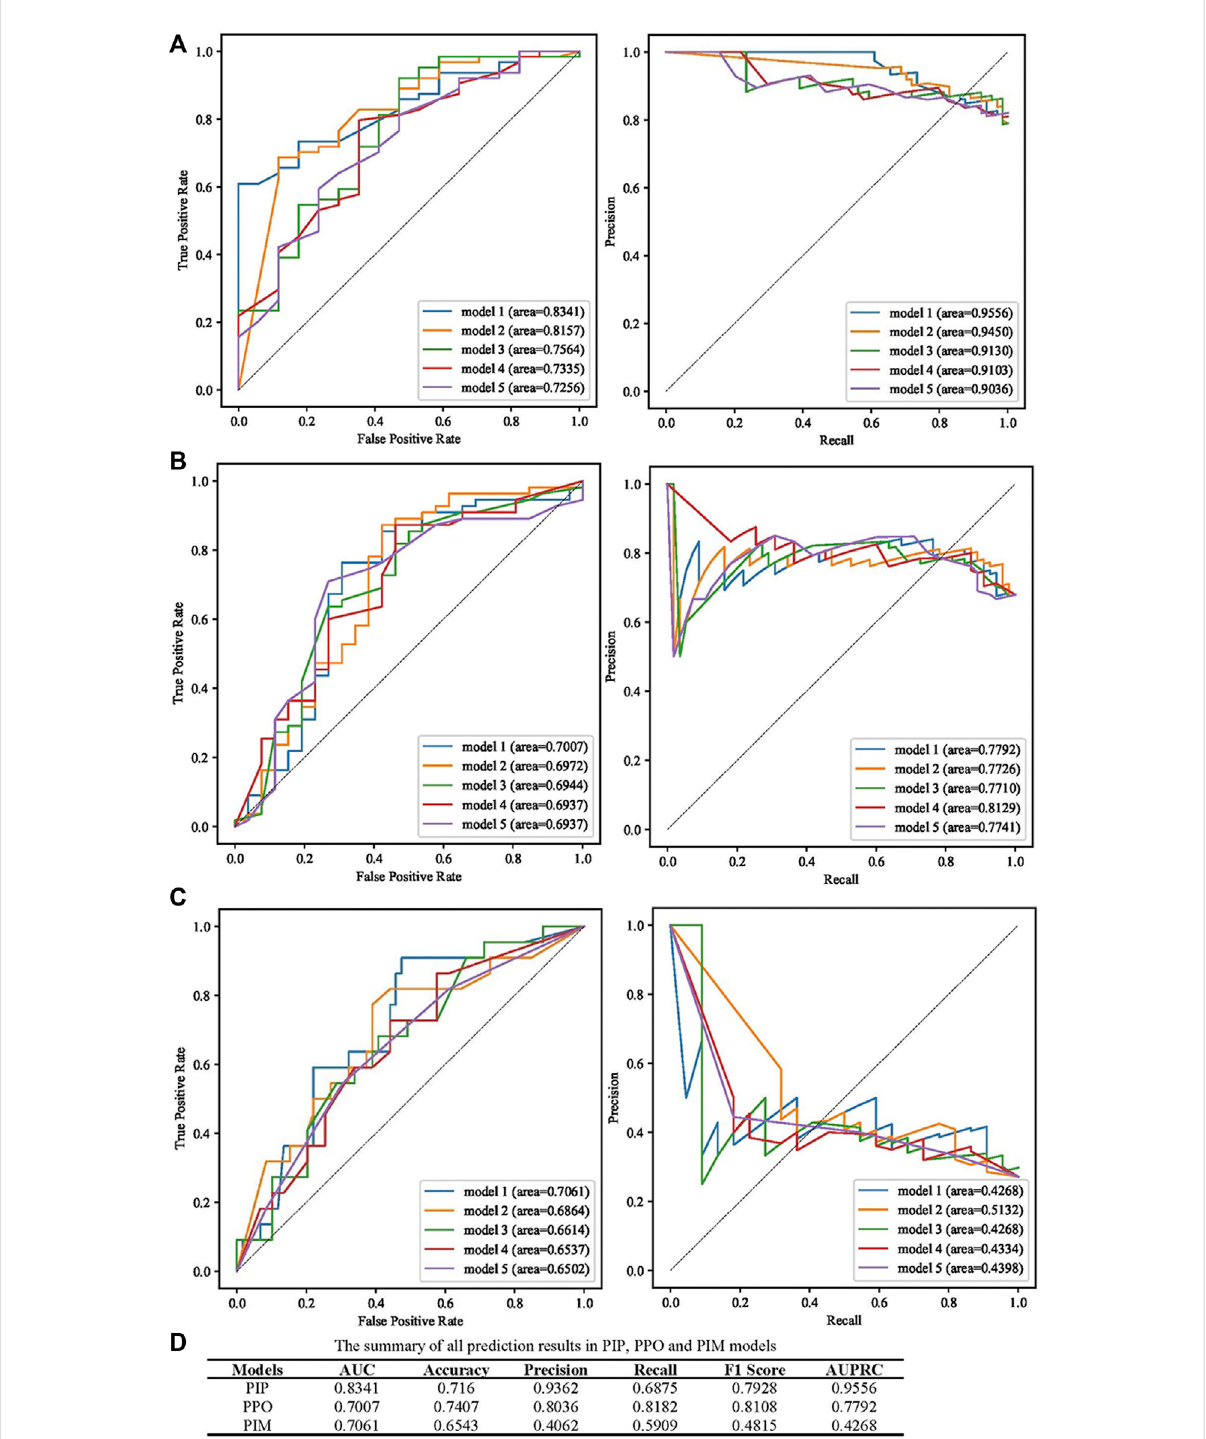
FIGURE 3 Summary of the performance of PIP, PPO, and PIM model. (A) The results of AUC and AUPRC in the best fi ve PIP model. (B) The results of AUC and AUPRC in the best fi ve PPO model. (C) The results of AUC and AUPRC in the best fi ve PIM model. (D) The summary of AUC, accuracy, precision, recall, F1 score, AUPRC in the best PIP, PPO, and PIM